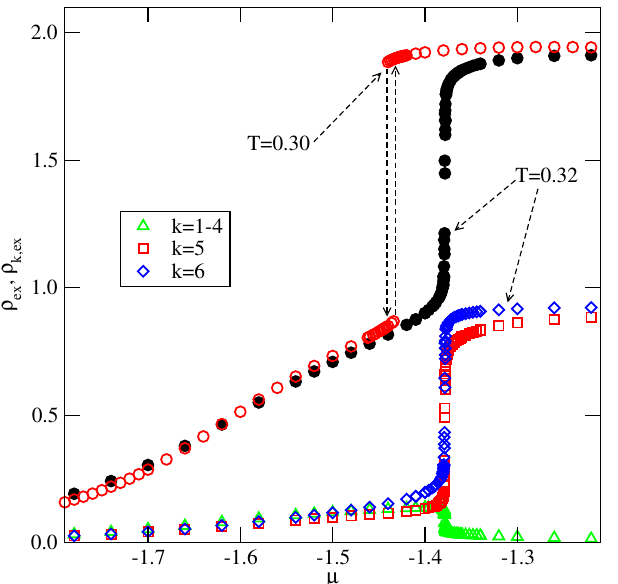
Figure 17. The excess adsorption isotherms for the system with V o = − 1.0 at T = 0.30 and